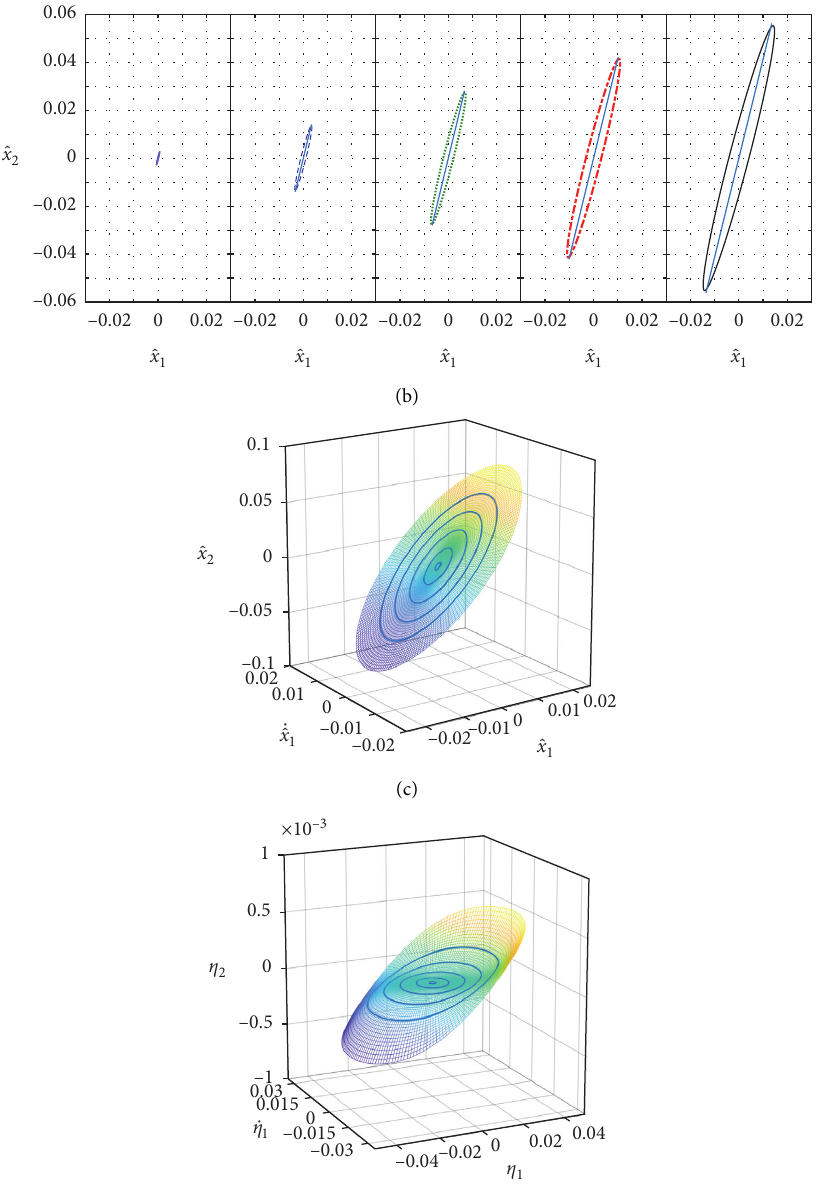
Figure 8: The forced responses of a type III two-stage isolator in primary resonance, for 􏽢 k � 0, and the corresponding free periodic h 1 motions on the approximate NNM invariant manifold for the underlying conservative system. (a) Displacement amplitude-frequency responses for the payload and the ones for the lower stage of the isolator under harmonic force excitations with different amplitude F : pink solid line represents F � 0 . 0001; blue dashed line represents F � 0 . 0005; green dotted line represents F � 0 . 0010; red dashed- dotted line represents F � 0 . 0015; black solid line represents F � 0 . 0020; the other system parameters are the same as in Figure 2. (b) Five representative forced responses in primary resonance of the system shown in different line styles, which correspond, respectively, to the solid points on the curves in (a) with the same color and line style. Five corresponding free periodic trajectories of the underlying conservative system are shown in solid lines. (c-d) The approximation of the NNM invariant manifold for the displacement ( 􏽢 x , _ 􏽢 x ) and η ( η , _ η ) , respectively, and the five free periodic trajectories in (c) or (d) corresponding to the free motions constraint 􏽢 x 2 1 1 2 1 1 in (b). To ensure the numerical accuracy, the parameters set in the numerical solution procedure are N a � 41, with 40 equally sized � elements in the domain a | a ∈ [ 0 , 0 . 04 ]{ } , and N ϕ